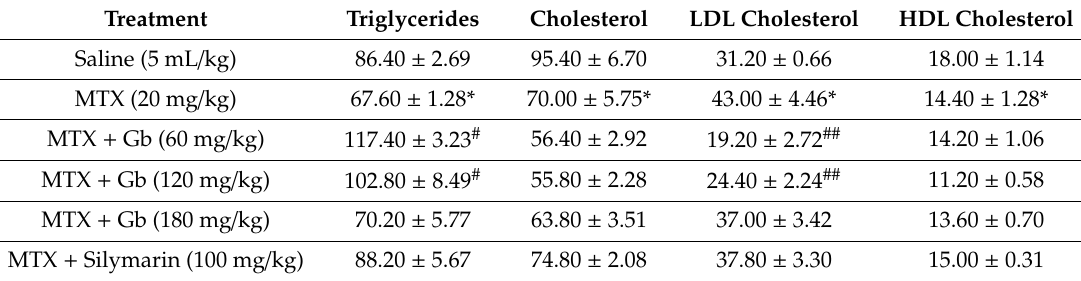
Table 2. E ff ect of Gb on fatty acid levels.